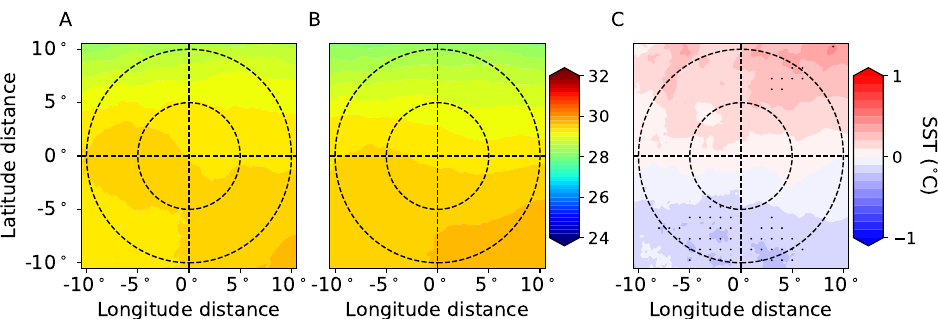
Figure 10. Composite maps of sea-surface temperature of ( A ) RG and ( B ) non-RG events and ( C ) the difference between ( A ) and ( B ). SST data are from the ERA5 reanalysis and are obtained for two days before TC approach. The units for x - and y -axis are degrees. Stippled areas in the right panel indicate that the differences are statistically significant at the 99% confidence level based on Student’s t -test. The two circles are placed at radii of 5 and 10 degrees from the TC